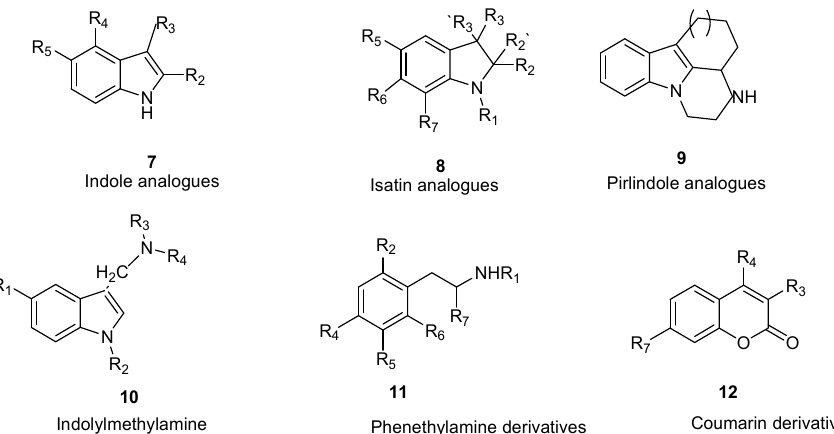
Figure 5. Main scaffolds of indole, isatin, pirlindole, indolylmethyl amine, phenethylamine, and coumarin studied as MAO-inhibitors. (R 1 = OH, R 2 c = MeO, R 3 = MeO, R 4 = H or OH R 5 = H, R 6 = CHMe 2 , R 7 = NHMe, NMe 2 , NH 2 ).